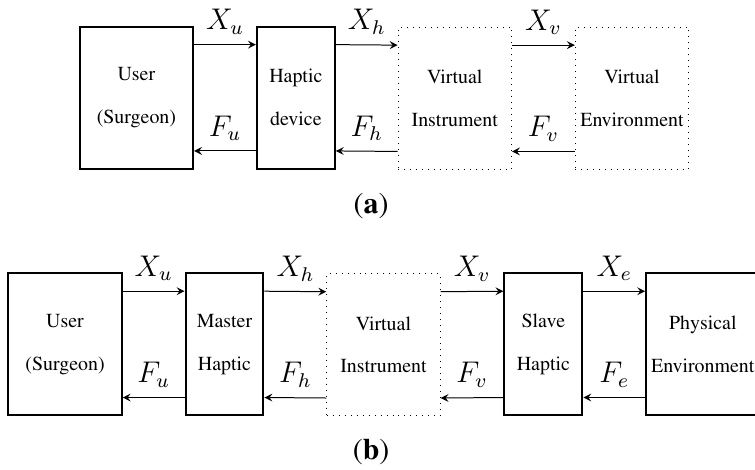
Figure 1. Conventional virtual prototyping method ( a ) compared to the proposed approach ( b ), where the virtual instrument is used in a real environment, reducing the complexity and inaccuracy of the simulation. ( a ) Virtual prototyping includes simulation models of the instrument and the environment; ( b ) with the proposed method, the simulated virtual instrument is used in a physical